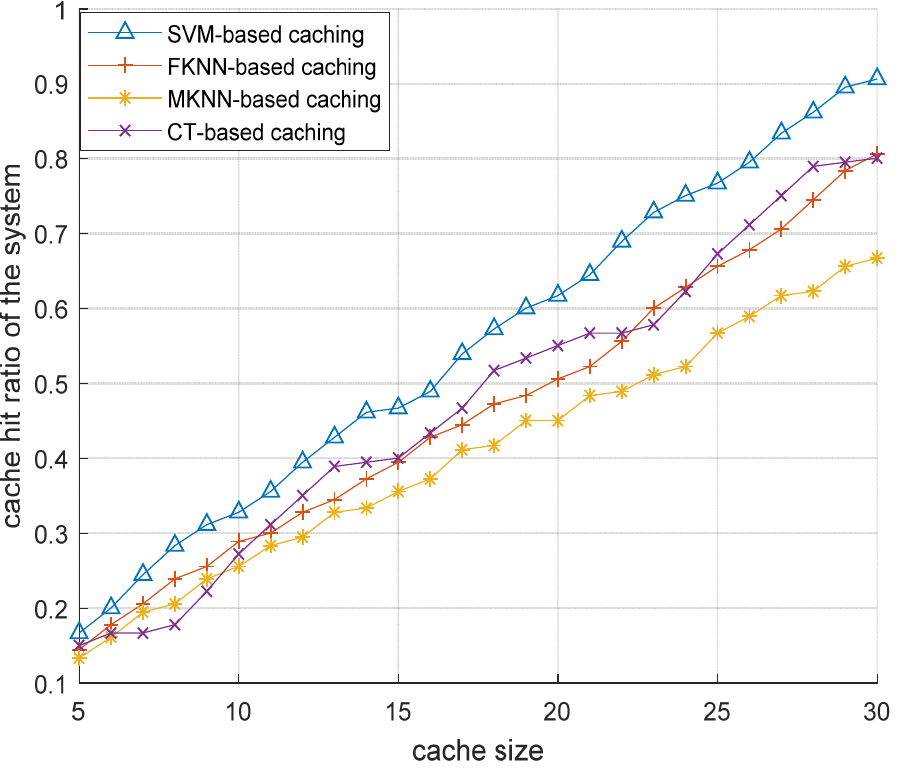
Figure 5. Performance evaluation of content caching based on SVM at D2D assisted multitier cellular networks.